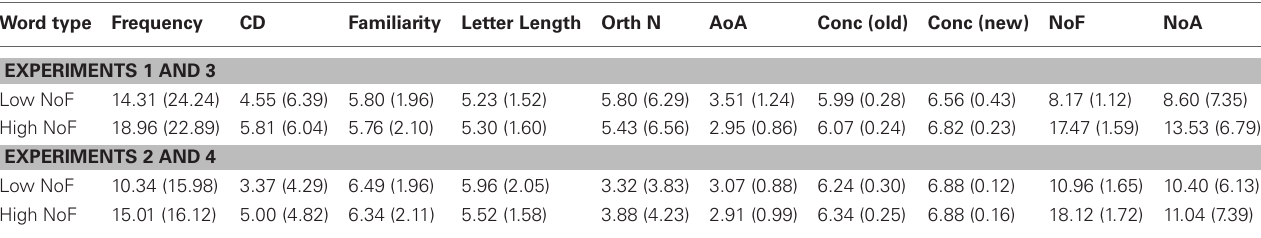
Note: CD, contextual diversity; NoF, number of features; orth N, orthographic neighborhood size; AoA, age of acquisition; Conc, concreteness; NoA, Number